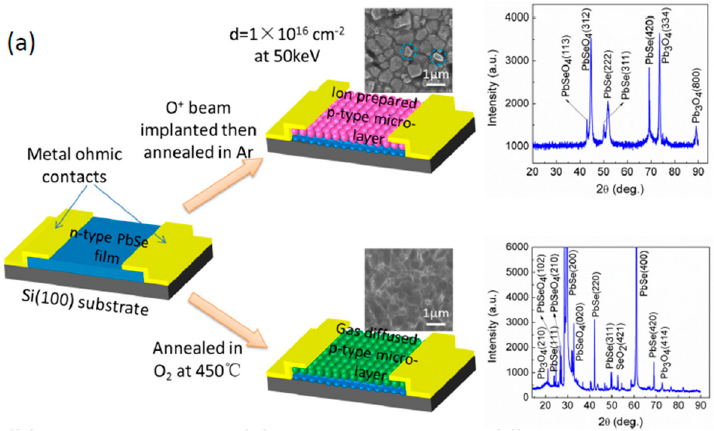
Figure 13. Cont . Figure 13.